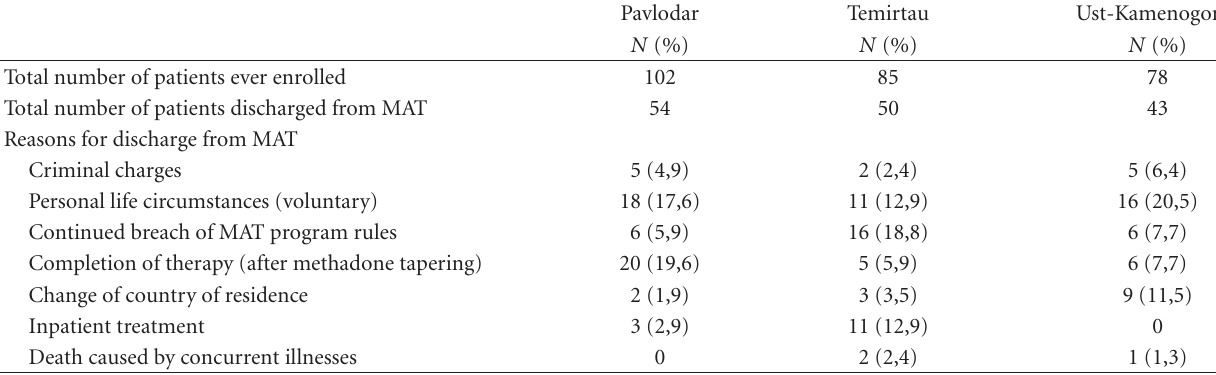
Table 4: Reasons for patient discharge from medication-assisted therapy in Kazakhstan, by treatment site.